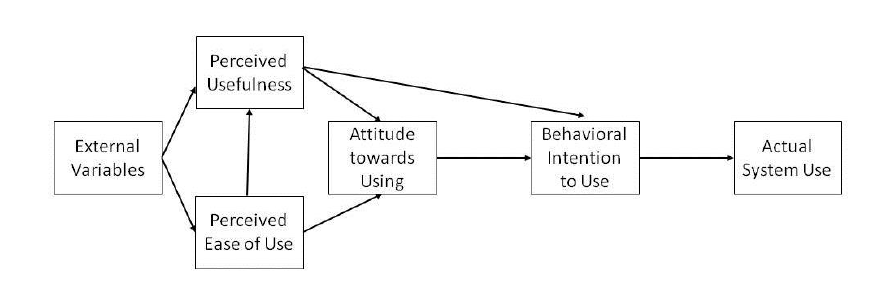
Figure 1. Technology acceptance model (Davis,